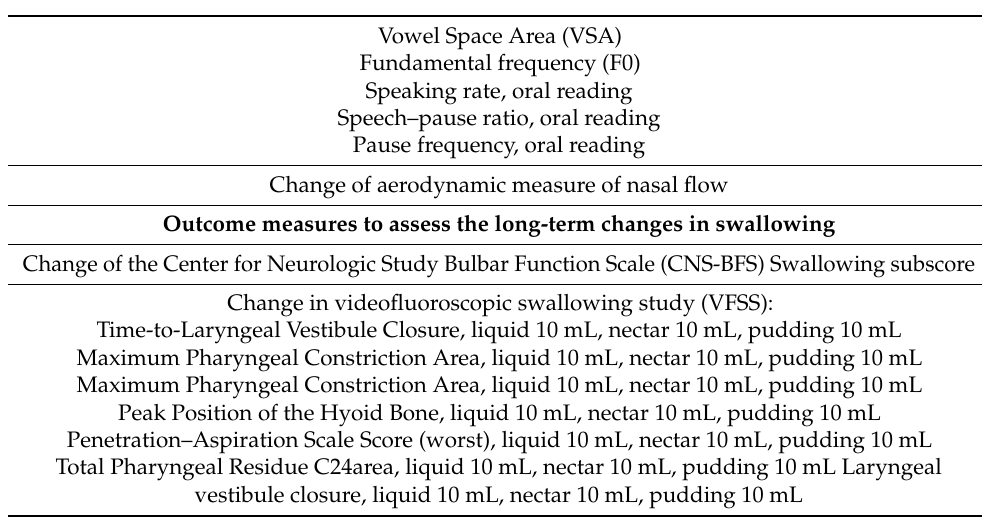
Table 32. Cont. Vowel Space Area (VSA) Fundamental frequency (F0) Speaking rate, oral reading Speech–pause ratio, oral reading Pause frequency, oral reading Change of aerodynamic measure of nasal flow Outcome measures to assess the long-term changes in swallowing Change of the Center for Neurologic Study Bulbar Function Scale (CNS-BFS) Swallowing subscore Change in videofluoroscopic swallowing study (VFSS): Time-to-Laryngeal Vestibule Closure, liquid 10 mL, nectar 10 mL, pudding 10 mL Maximum Pharyngeal Constriction Area, liquid 10 mL, nectar 10 mL, pudding 10 mL Peak Position of the Hyoid Bone, liquid 10 mL, nectar 10 mL, pudding 10 mL Penetration–Aspiration Scale Score (worst), liquid 10 mL, nectar 10 mL, pudding 10 mL Total Pharyngeal Residue C24area, liquid 10 mL, nectar 10 mL, pudding 10 mL Laryngeal vestibule closure, liquid 10 mL, nectar 10 mL, pudding 10